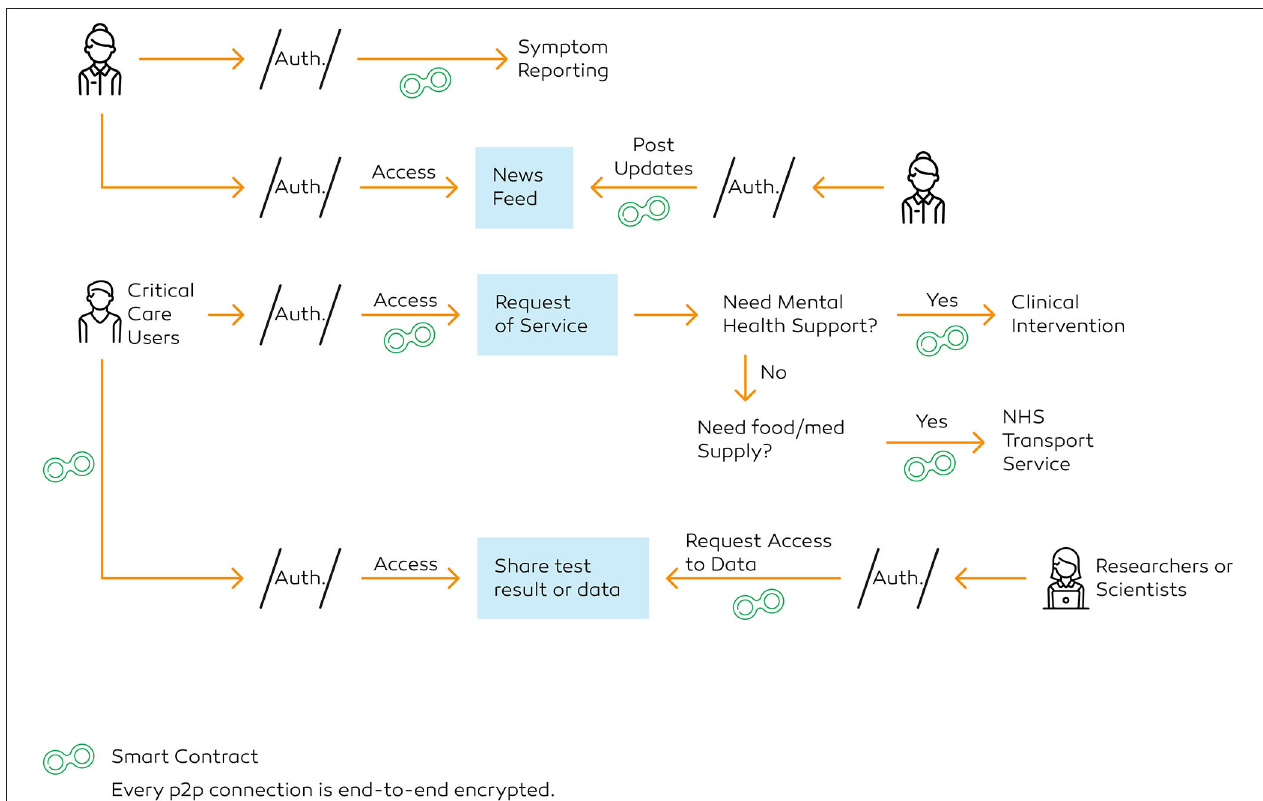
FIGURE 5 | User authorisation and interaction